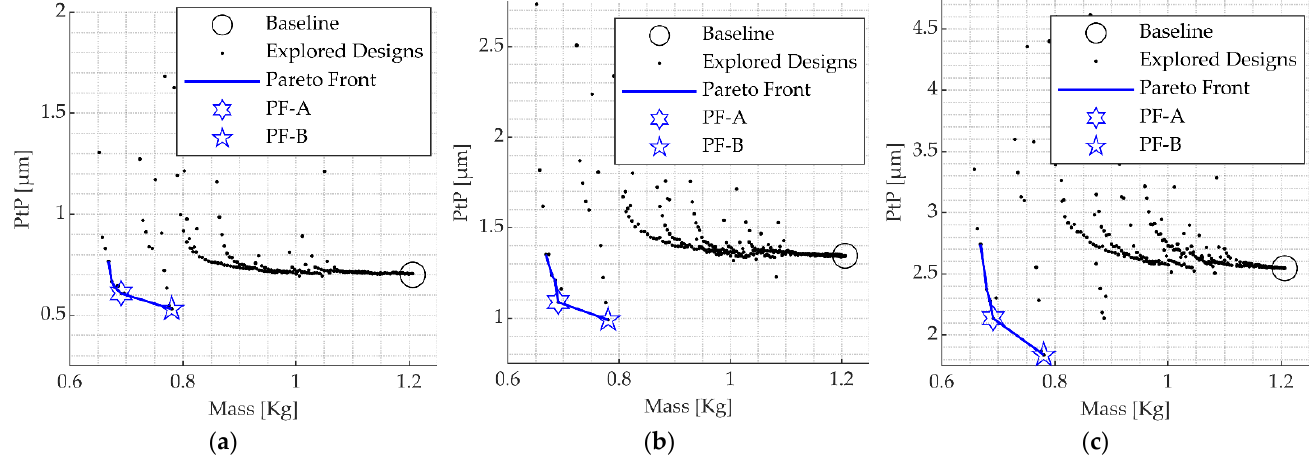
Figure 10. PtP vs. mass trend for different values of torque: ( a ) 50 nm; ( b ) 100 nm; ( c ) 200 nm.